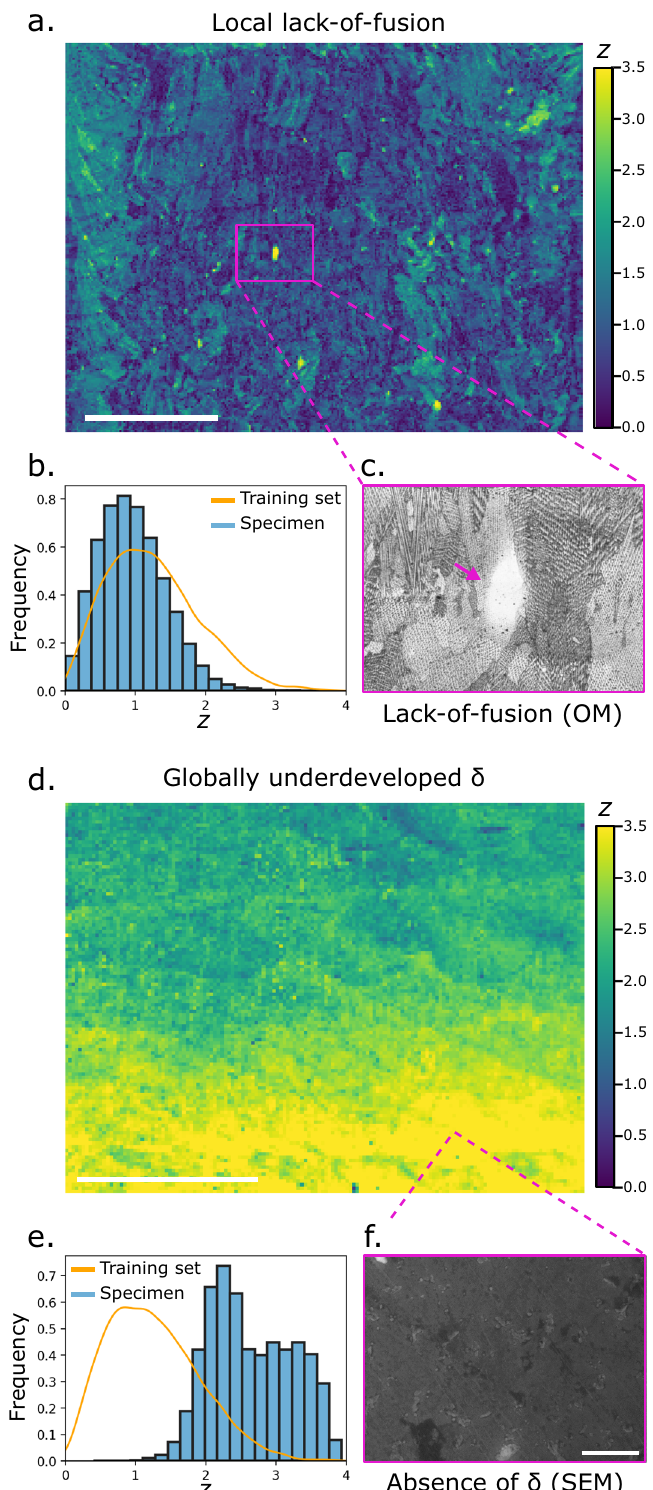
Fig. 6 Detection of anomalies and systematic bias in DRM datasets. Applying anomaly detection to new directional re fl ectance datasets enables to preemptively detect and discard unrepresentative data, which is not suitable for orientation imaging by the EulerNet model. a Anomaly detection in a regular specimen containing lack-of-fusion defects. When mapping z across the surface, the defects get highlighted by the anomaly detection model. b The distribution of z in this specimen is otherwise close to that of the training set distribution. c An example of lack-of-fusion defect seen under the optical microscope. d In a specimen with underdeveloped or absent δ phase precipitates exhibiting a globally high z -score. e The distribution of z is shifted compared to that of the training set. f Under SEM, no δ phase precipitates are visible on the specimen ’ s surface in the area close to the baseplate. The scale bars in ( a , d ) represent 5 mm and the scale bar in ( f ) represents 5